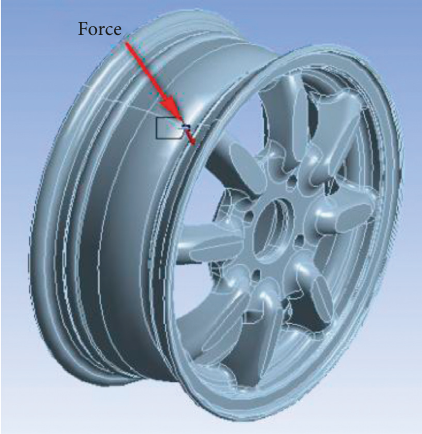
Figure 8: Wheel response